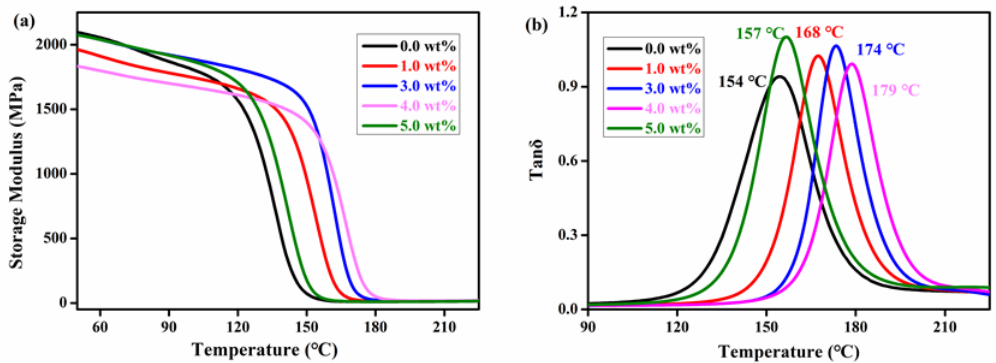
Figure 7. Dynamic mechanical properties of EP and its composites.